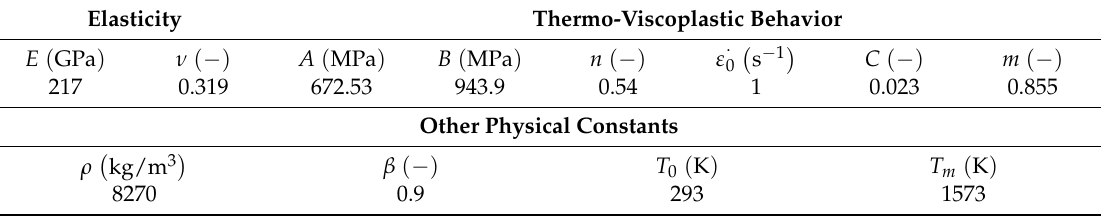
Table 4. Physical properties and Johnson–Cook parameters of Haynes 282 at room temperature. Elasticity Thermo-Viscoplastic Behavior